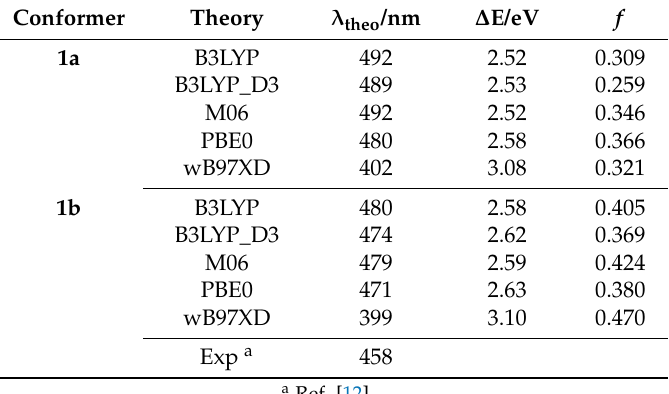
Table 2. Vertical excitation energies, ∆ E in eV, absorption wavelengths, λ theo in nm, and oscillator strength, f , computed in dichloromethane solvent and employing different exchange–correlation functionals for the two minima of compound 1 .